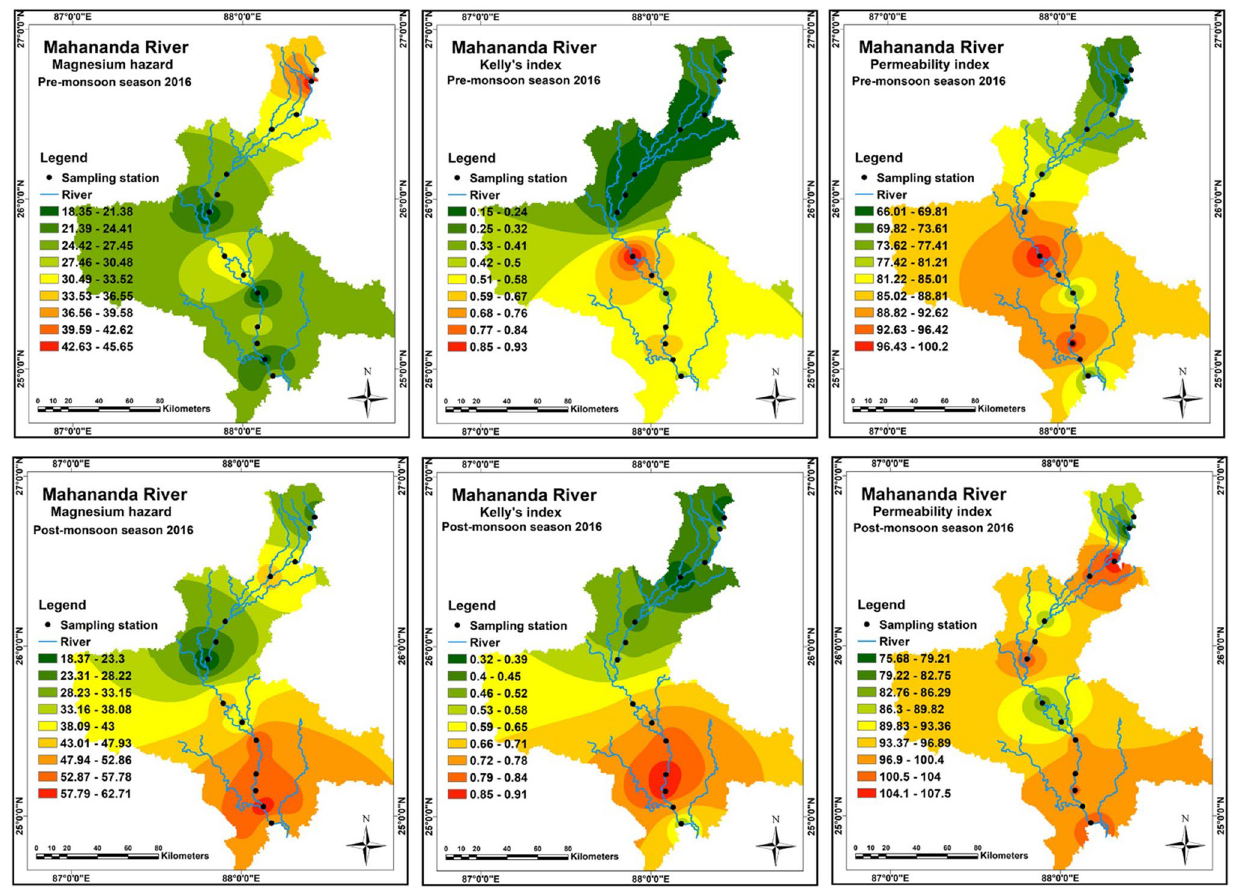
Fig. 11 Spatial variations of magnesium hazard (MH), Kelly’s index (KI) and permeability index